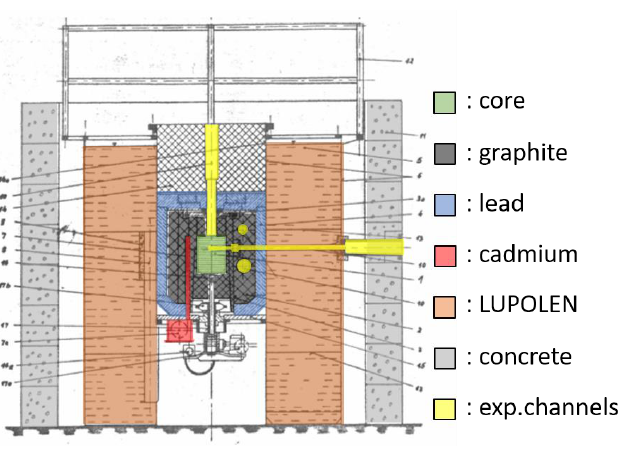
Fig. 1 - Scheme of the SUR-100 reactor